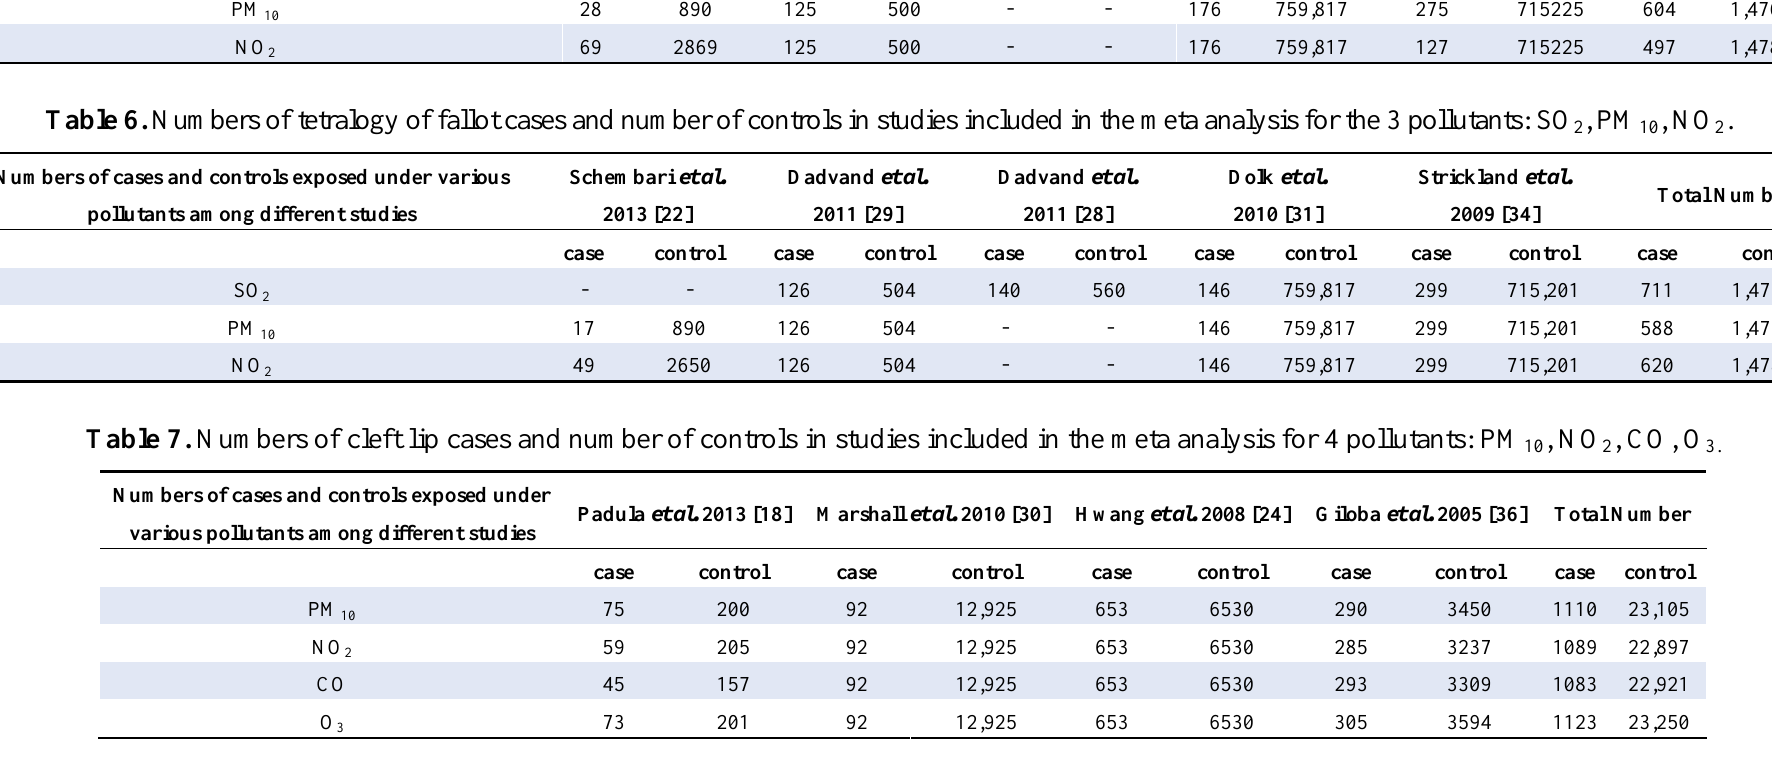
Table 5. Numbers of coarctation of aorta cases and number of controls in studies included in the meta analysis for 3 pollutants: SO Numbers of cases and controls exposed under various